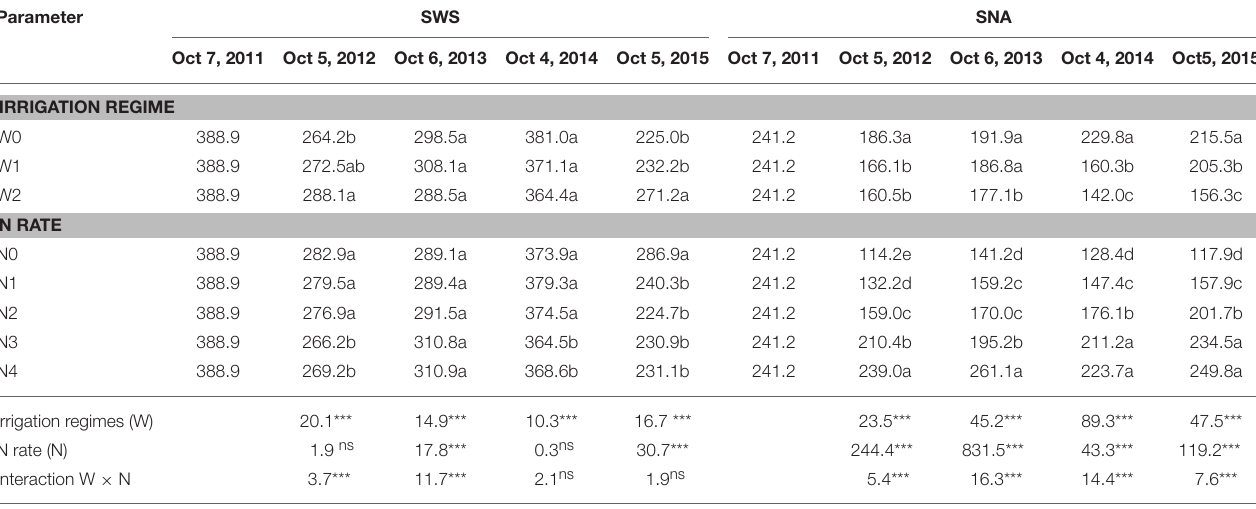
TABLE 3 | The soil water storage (SWS; mm) and soil NO 3 -N accumulation (SNA; kg ha − 1 ) in the 0–1.6m soil profile prior to sowing winter wheat.